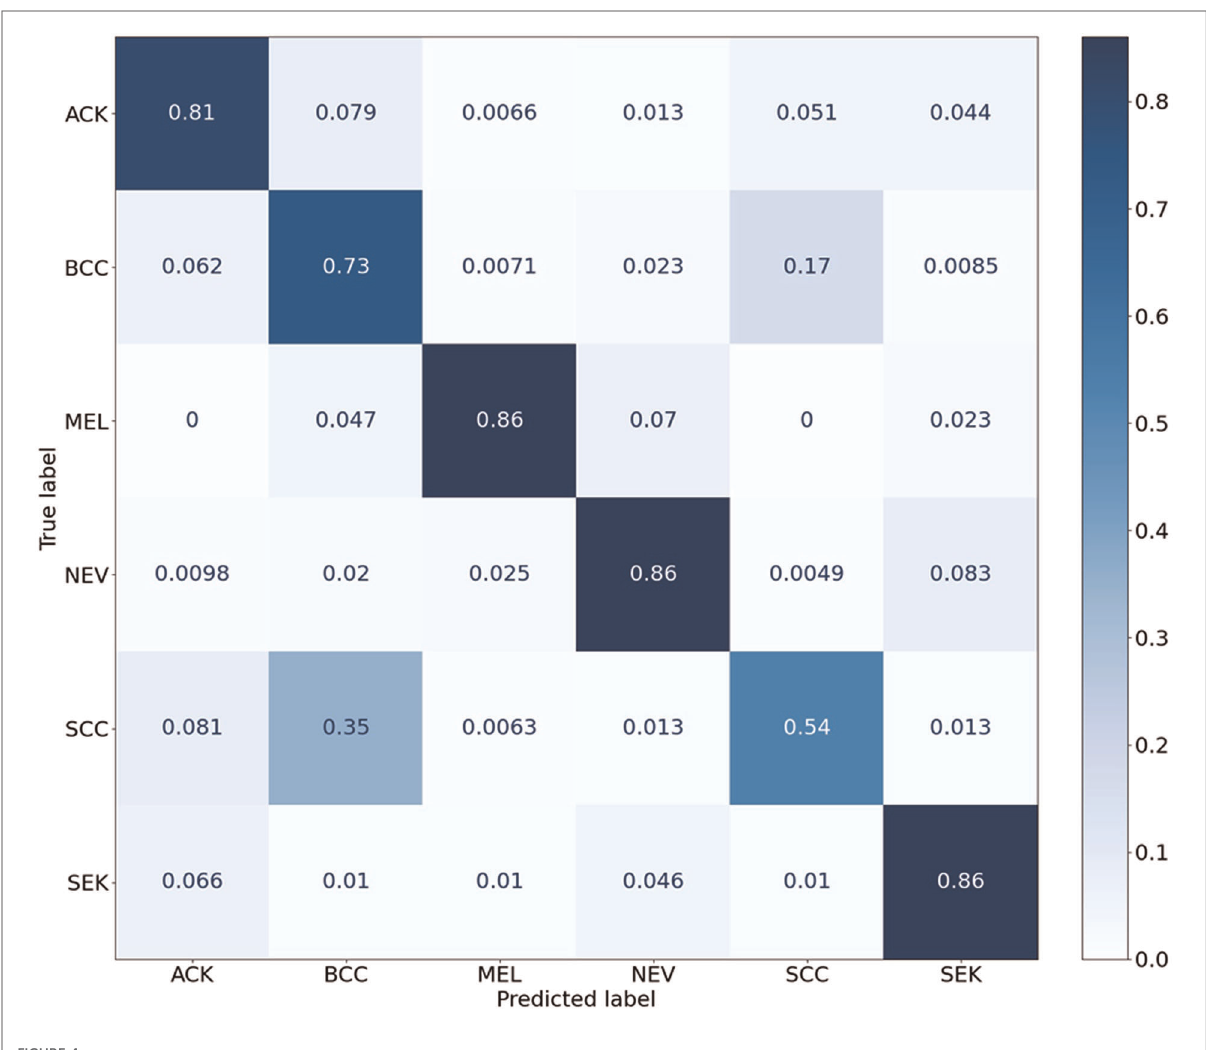
FIGURE 4 Confusion matrix of different types of skin lesions.